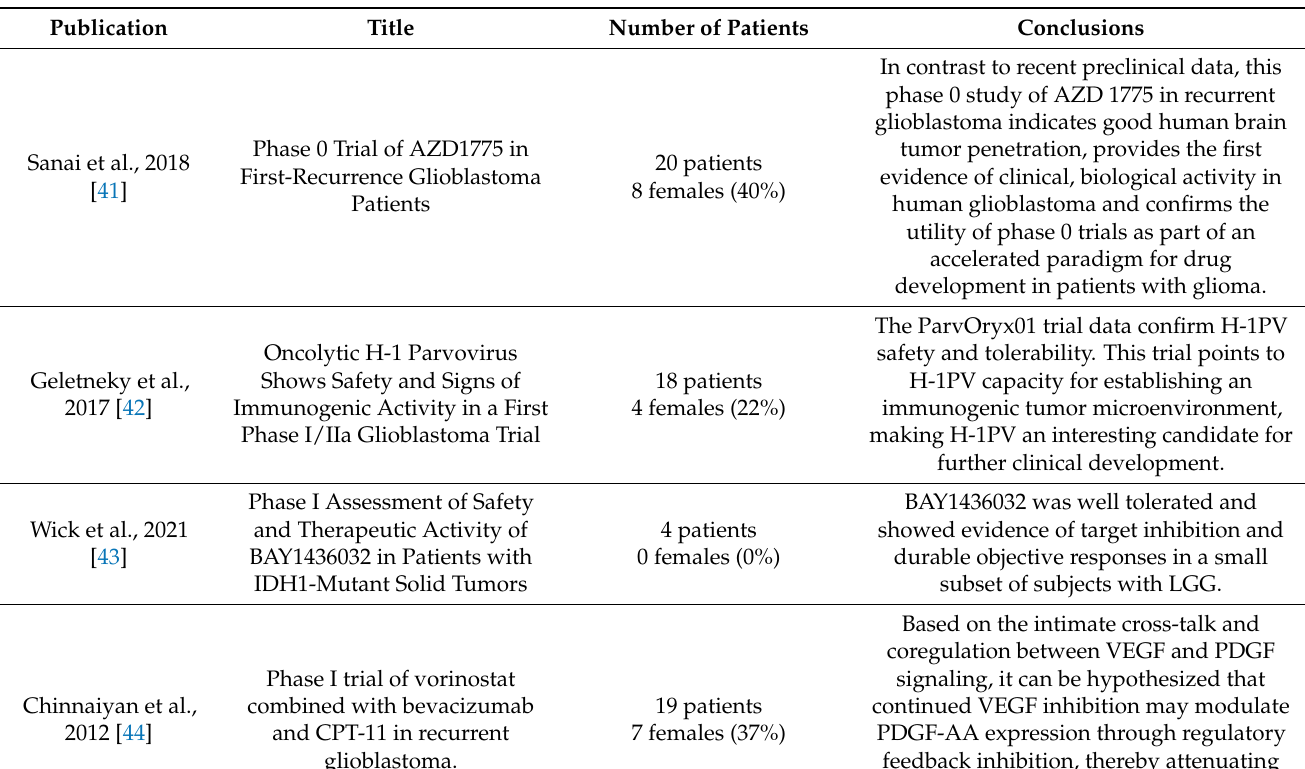
Table 2. Prospective studies in glioma illustrating the number of patients included in the study with % female inclusion and generated